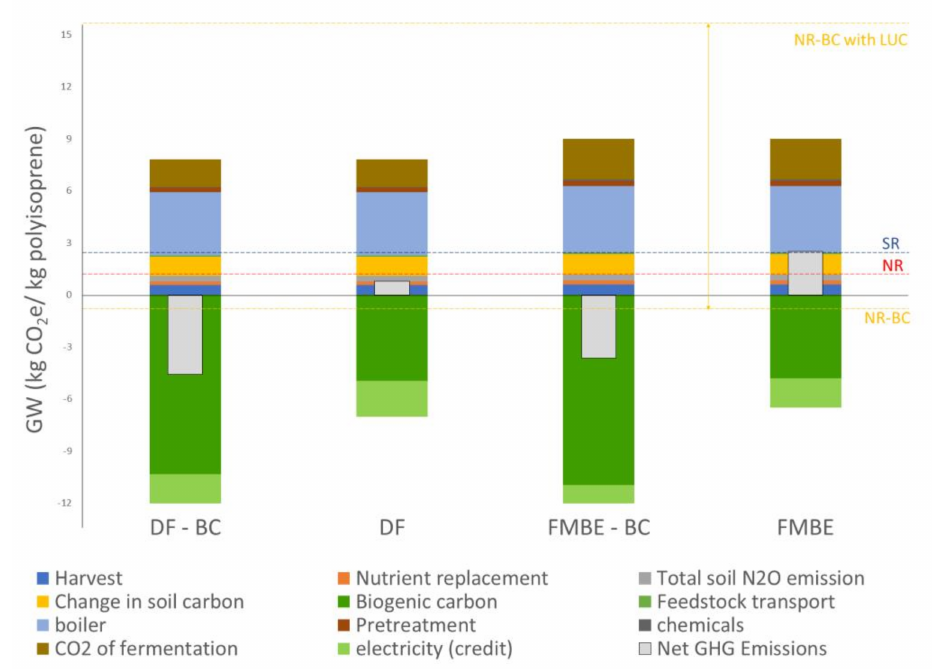
Figure 3. The 100-year GW of select parameters for the scenarios of producing polyisoprene, DF-BC = Direct fermentation with sequestered biogenic carbon; DF = direct fermentation without sequestered biogenic carbon; FMBE-BC = fermentation to methyl butenol with sequestered biogenic carbon; FMBE = fermentation methyl butenol without sequestered biogenic carbon; SR = synthetic rubber; NR = natural rubber; NR-BC = natural rubber with biogenic carbon; NR-BC = natural rubber including biogenic carbon and land use converted from forests to rubber plantations.